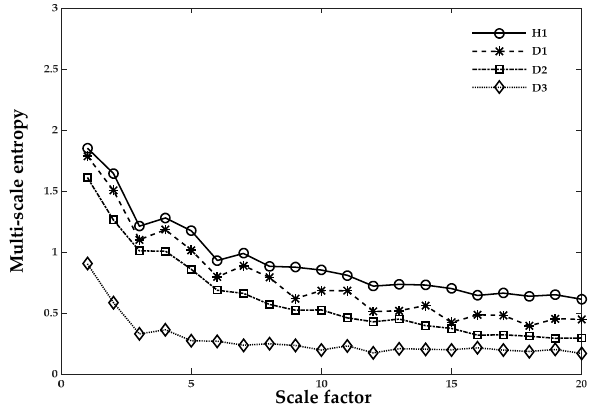
Figure 7. REB Case 1 and Product Function 1 with an average of eight segments per set. Scale factor 20 vs. multi-scale values (sample entropy) were used to obtain the results of the MSE technique.